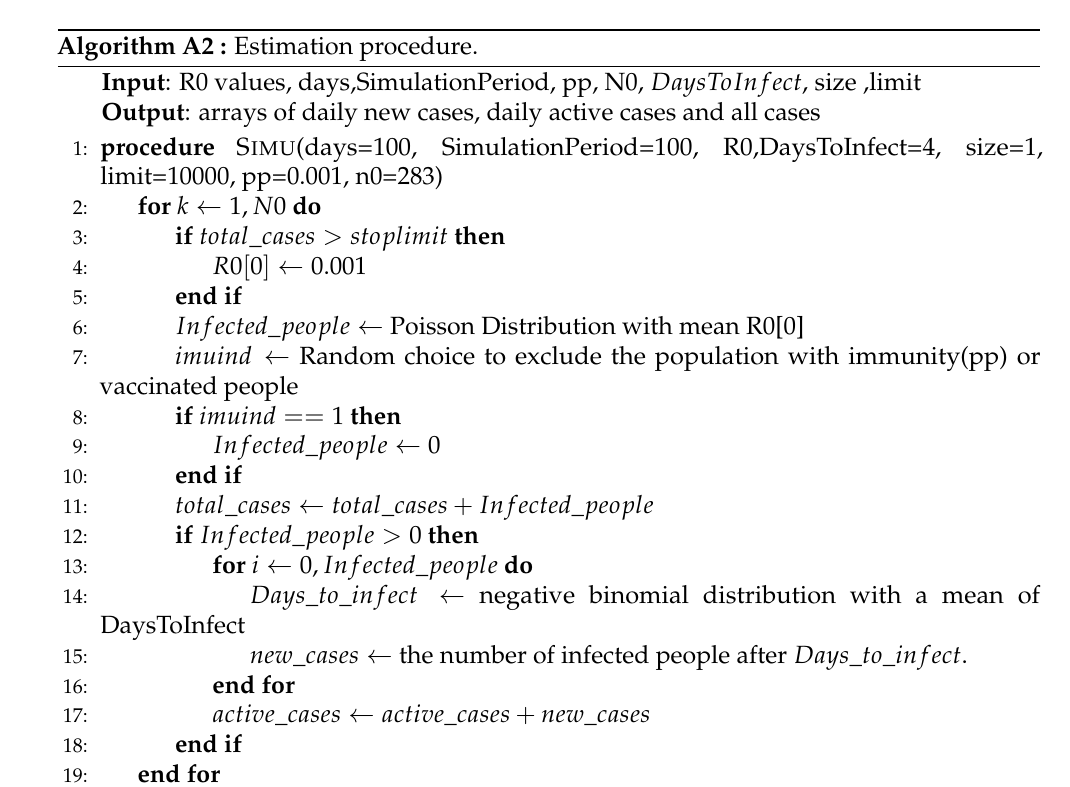
Algorithm A2 : Estimation